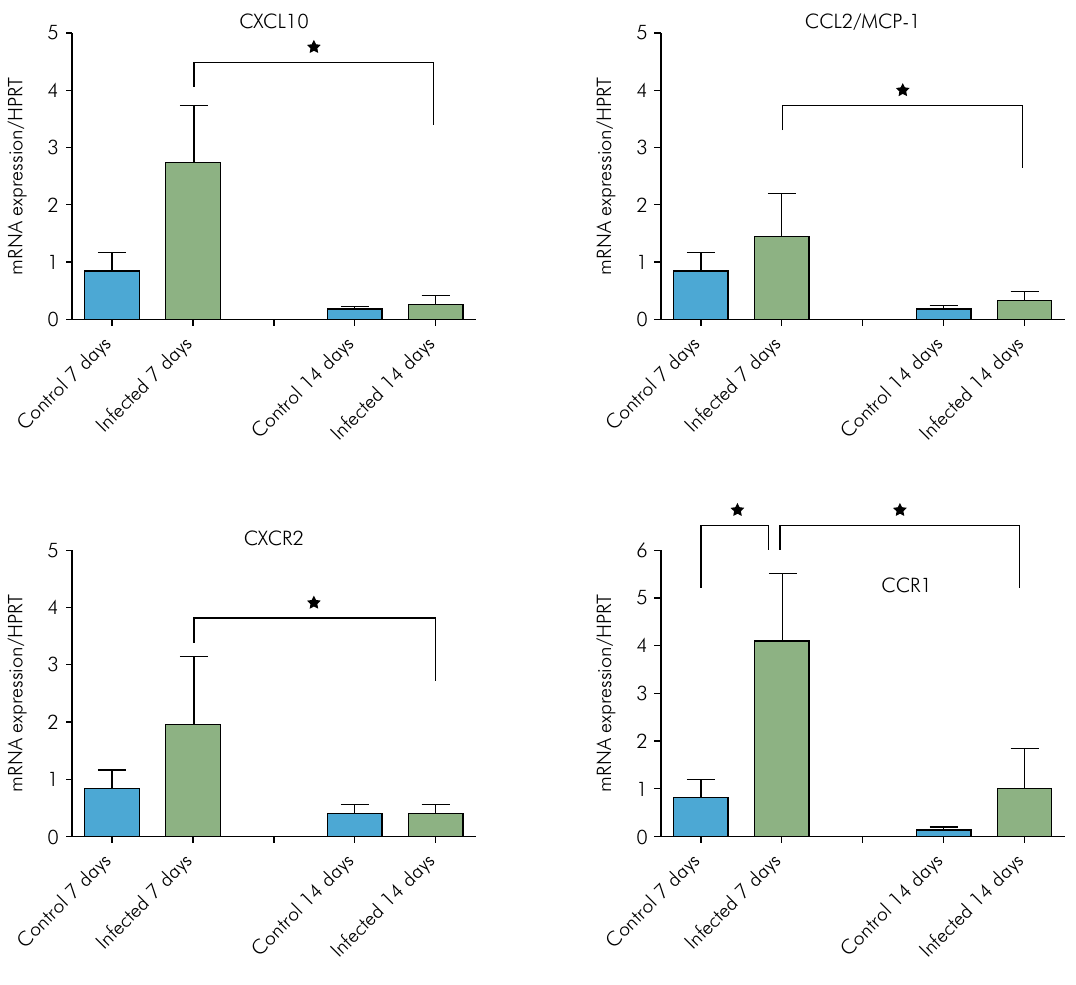
Figure 2. mRNA expression of the chemokines CXCL10, CCL2/MCP-1, CXCR2 and CCR1 analysed by real-time PCR in response to experimental infection in GF mice by microbial bi-association of E. faecalis , and F. nucleatum . The relative mRNA expression levels were quantified compared with those of the internal control (HPRT). The data were expressed as the mean ± standard error of two independent experiments with six mice per group. The bars represent the mean values of the samples recovered from the axenic mice, and the error bars represent the standard errors of the means. P<0.05 as determined by Student’s